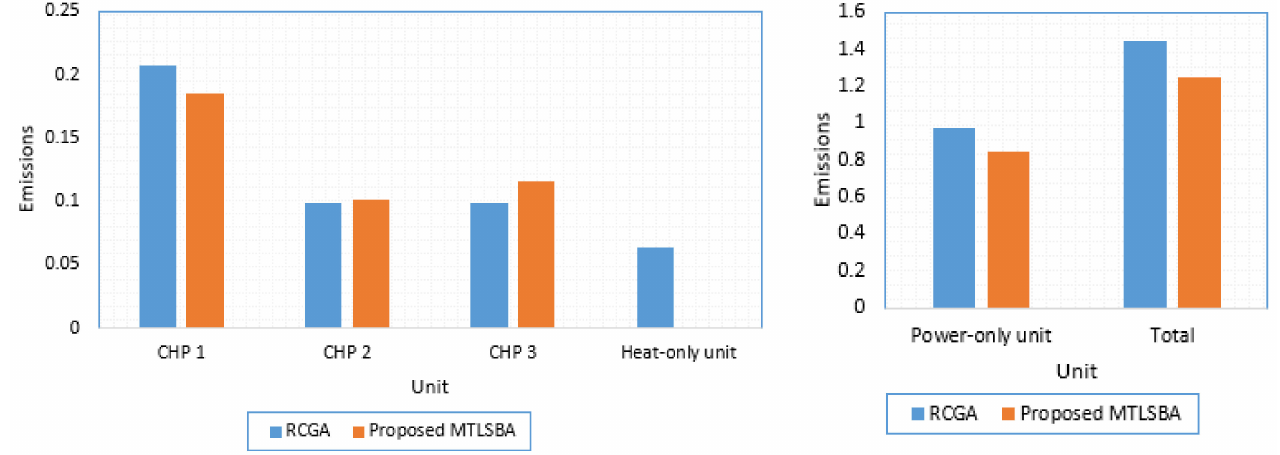
Figure 6. Emission rates for each unit related to the best emissions in Table